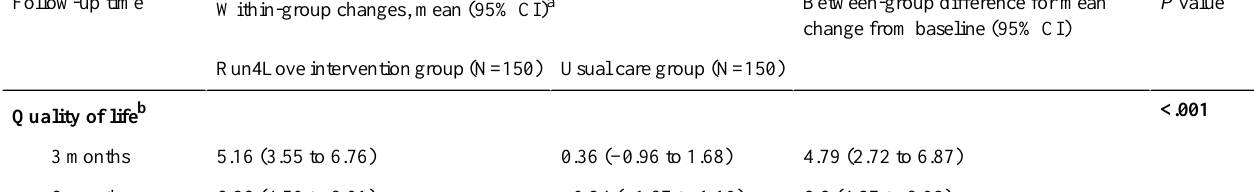
P valueBetween-group difference for